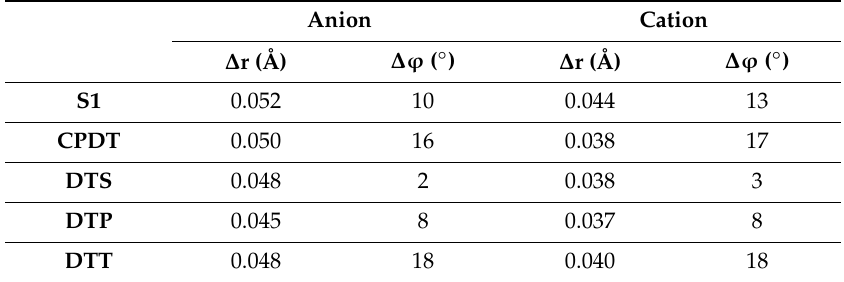
Table 2. Distortion between the neutral and ionic states of designed compounds (B3LYP / 6–311G (d, p) calculations, bond distances in angstrom and bond angles in